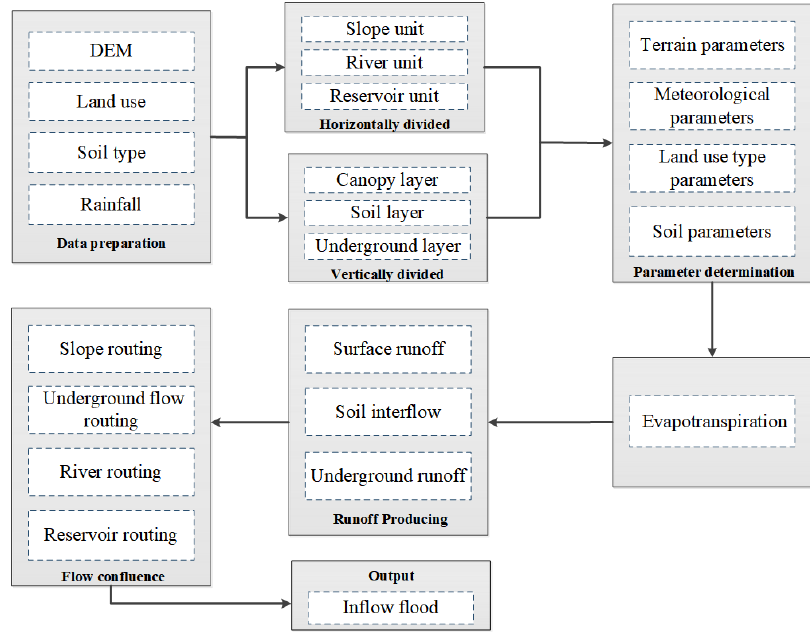
Figure 1. Framework of the Liuxihe